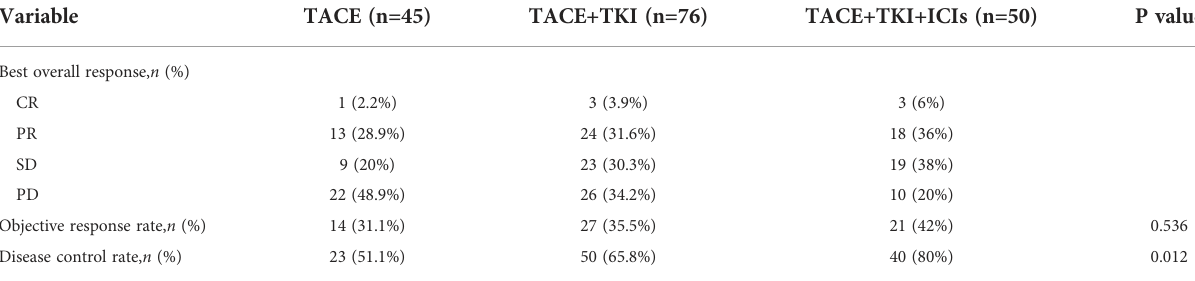
TABLE 2 Theraprutic efcacy of response.